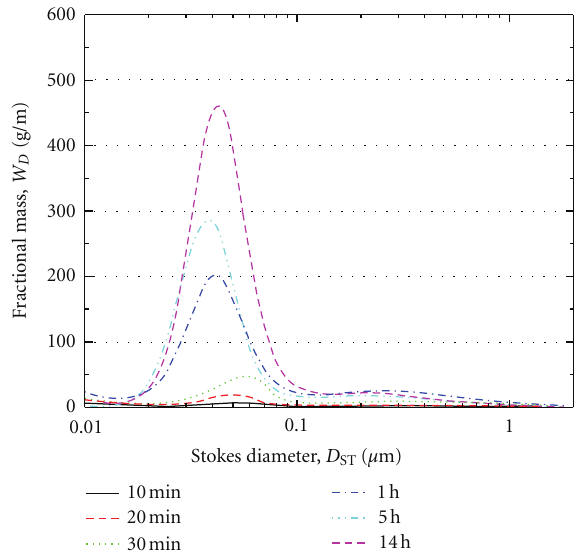
Figure 2: Particle size distributions of Arkema CNTs with increas- ing sonication time using a horn sonicator with flow cell at 10% amplitude.